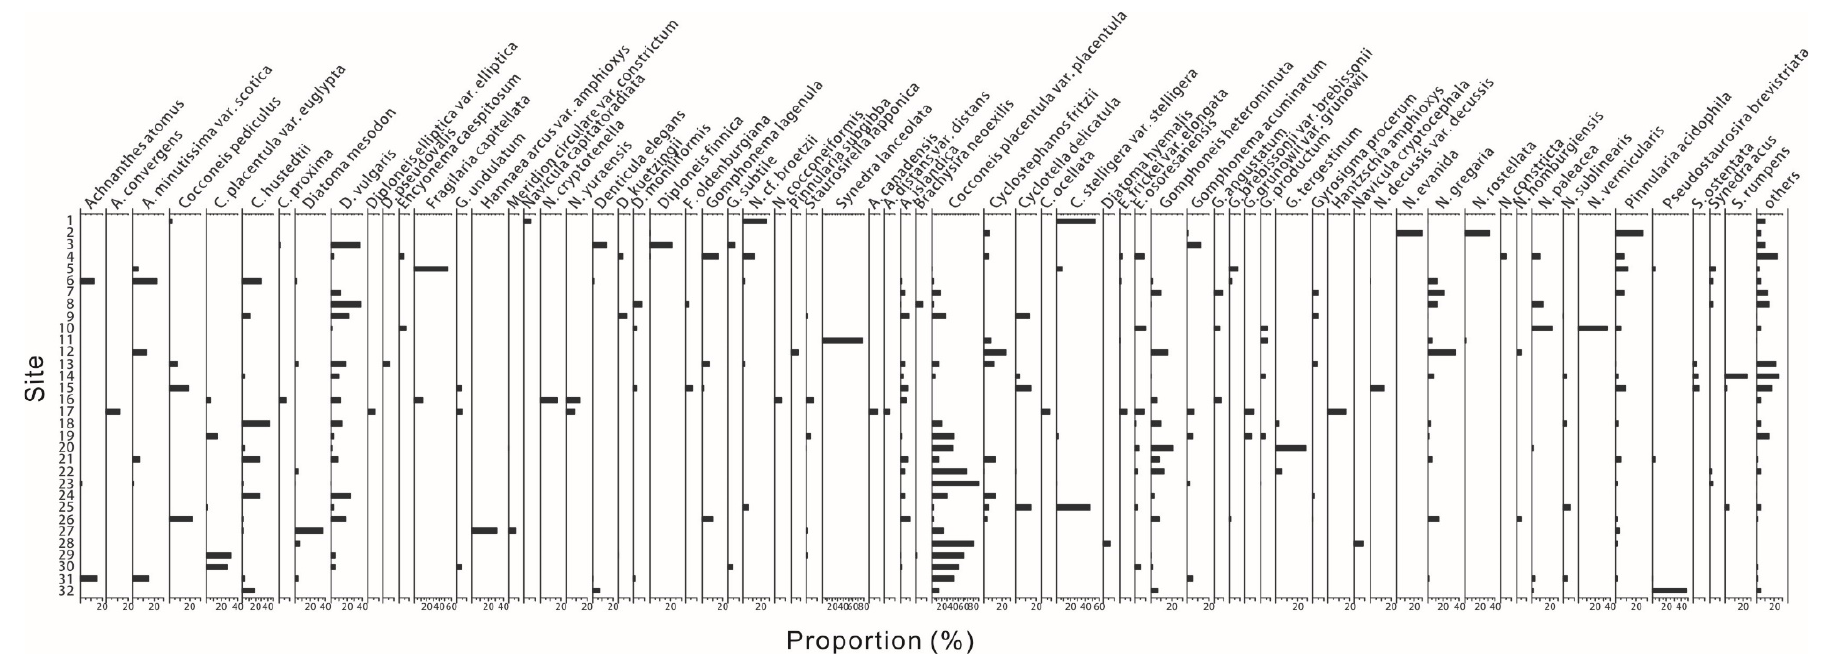
Figure 3. Diatom distribution for each sampling site. All the diatom species with a relatively low percentage are included in the category entitled as Others.